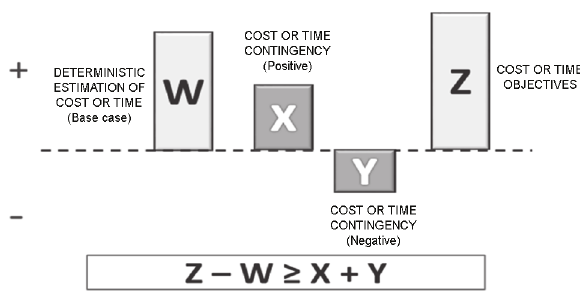
Figure 2. Joint management of positive and negative